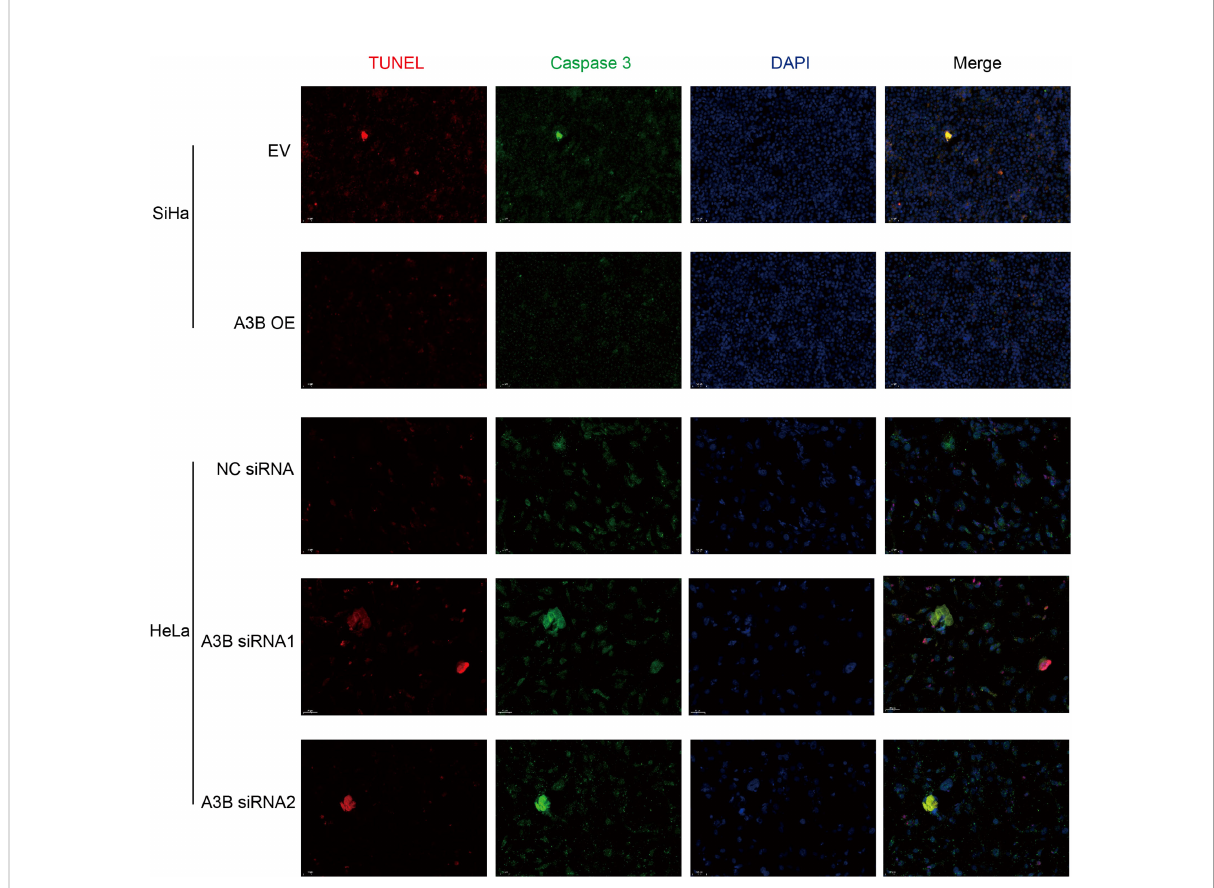
FIGURE 5 Relationship between apoptosis-associated proteins and protein expression of A3B. Representative image of fl uorescence. Red represents TUNEL, green represents caspase-3, and blue represents DAPI. A3B correlates inversely with the prevalence of cervical cancer